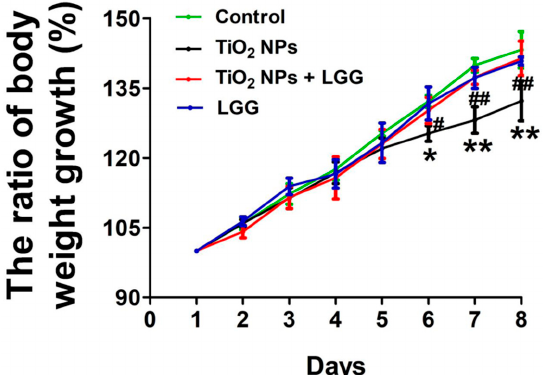
Figure 2. The ratio of body weight growth in the young rats after exposure TiO 2 NPs. * p < 0.05 and ** p < 0.01 versus the control group; # p < 0.05 and ## p < 0.01 versus the TiO 2 NPs group. n = 6, val- ues are presented as mean ± SD.